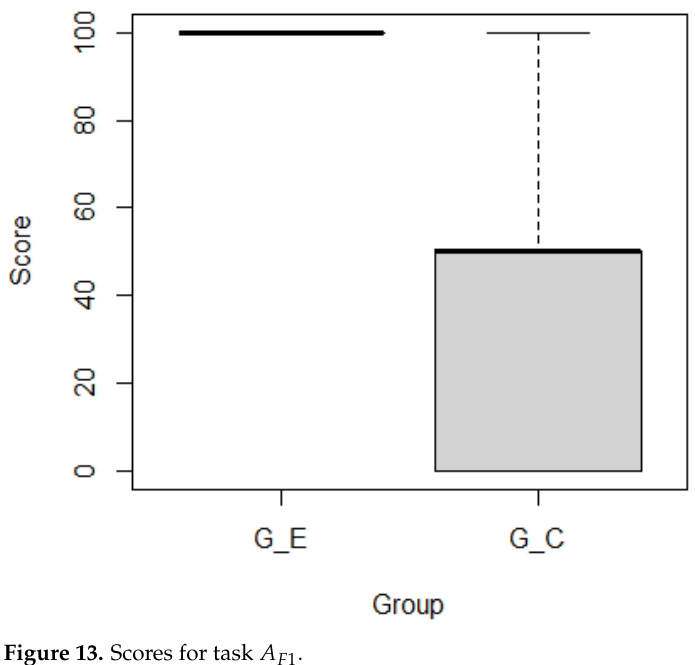
Figure 13. Scores for task A F 1 .